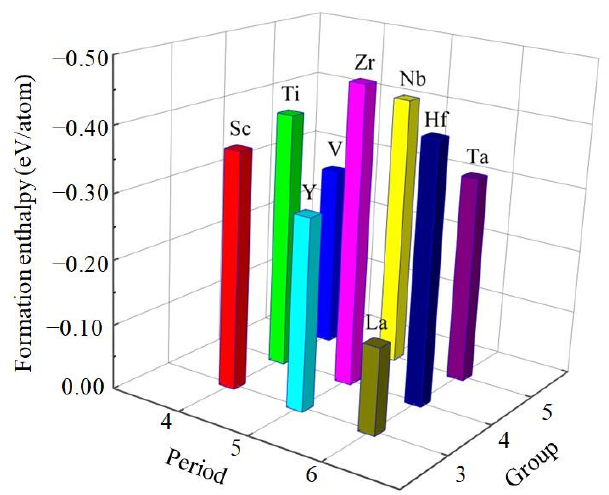
Figure 2. The calculated formation enthalpies of Al 3 TM